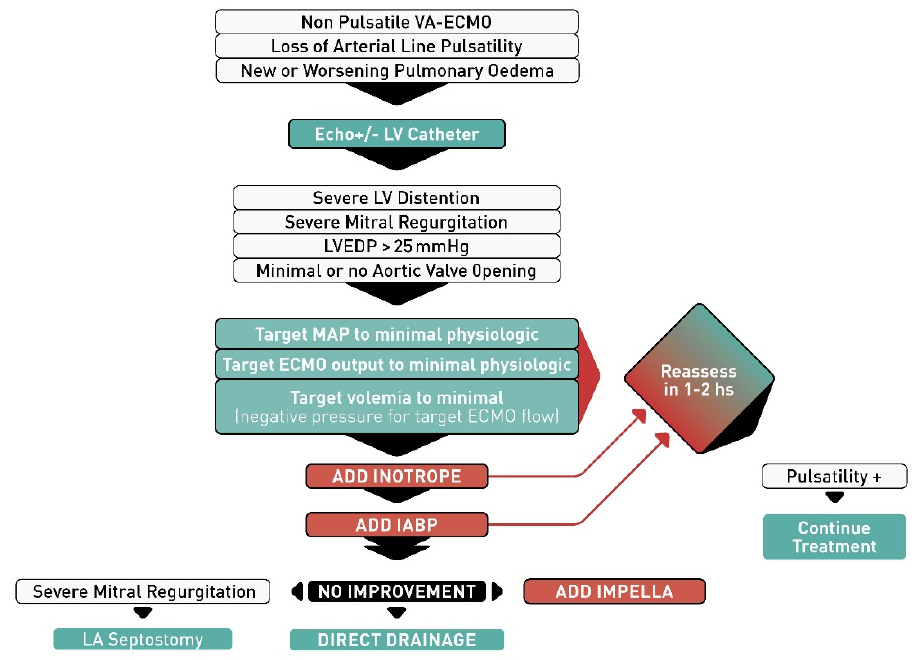
Figure 1. Algorithm proposed for left ventricular venting in patients with veno-arterial extracorporeal membrane oxygenation (VA-ECMO). Abbreviations: LV, left ventricular; LVEDP, left ventricular end-diastolic pressure; MAP, mean arterial pressure; IABP, intra-aortic balloon pump; LA, left atrial.